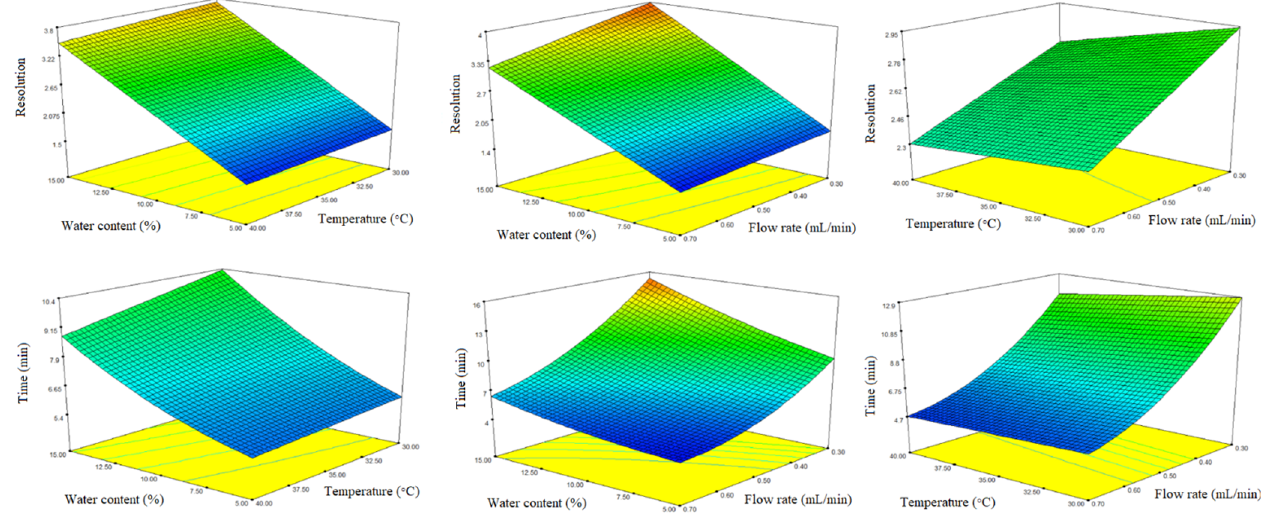
Figure 5. Three-dimensional response surface plots obtained for resolution and analysis time. Cold colors (blue) represent lower, while warm colors (red) represent higher values of the responses.